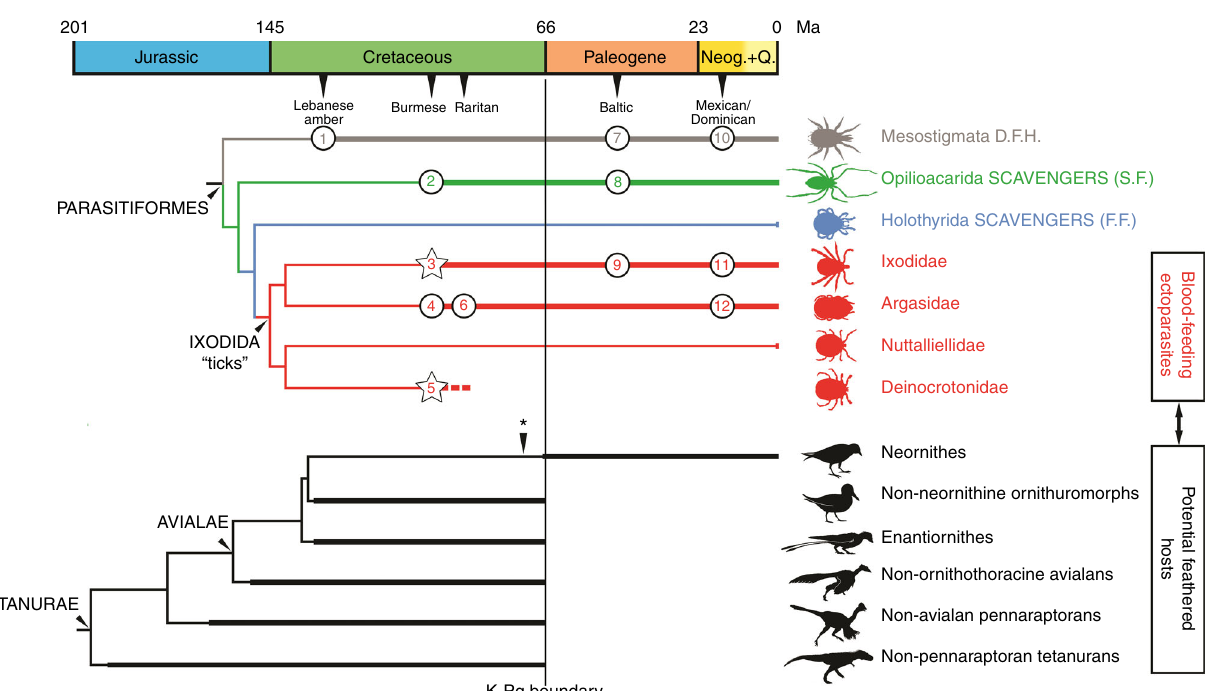
Fig. 10 Ticks and their possible feathered hosts in deep time. Simpli fi ed phylogenies of parasitiform Acari (top) and tetanuran Dinosauria leading to the bird lineage (bottom). Although fi lamentous integumentary structures are known in some ornithischians and pterosaurs, the latter are not represented for not belonging to the bird lineage. Time ranges supported by the fossil record are depicted with thick lines; those inferred appear in thin lines. Asterisk marks the inferred origin of modern birds (Neornithes). Known fossil occurrences of parasitiform mites (all in amber; stars correspond to tick records that can be related to feathered dinosaur hosts, presented in this paper; quaternary records excluded): Lebanese amber — 1, Mesostigmata indet.; Burmese amber — 2, ? Opilioacarus groehni ; 3 Cornupalpatum burmanicum , three specimens including the new one described herein entangled in a pennaceous feather; Compluriscutata vetulum , Amblyomma birmitum , and Amblyomma sp.; 4 Argasidae indet.; 5 Deinocroton draculi (herein); Raritan amber — 6, Carios jerseyi ; Baltic amber — 7, Sejus bdelloides ; Aclerogamasus stenocornis ; Microgynioidea indet.; 8 Paracarus pristinus ; ? Opilioacarus aenigmus ; 9 Ixodes succineus and Ixodes sp.; Mexican amber — 10, Dendrolaelaps fossilis ; Dominican amber — 11, Amblyomma sp.; 12 Ornithodoros antiquus . An unpublished, badly preserved specimen from Spanish amber (105 Ma) has been not included, but it could be assignable to Deinocrotonidae. See Supplementary Notes 3, 4, and 6 for inferred time ranges used, parasitiform records shown, oldest occurrences of dinosaur groups depicted, and discussion on feather evidence in non-avialan dinosaurs. Neog. + Q. Neogene and Quaternary, D.F.H. diverse feeding habits, S.F. solid feeders, F.F. fl uid